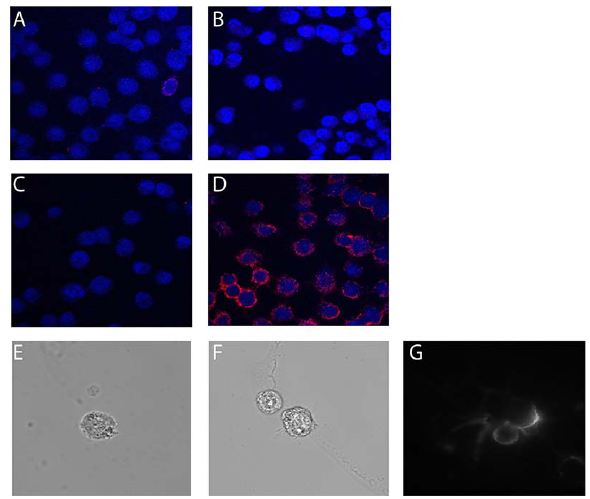
Figure 3. Immunofluorescence staining of undifferentiated HOG cells by 3064-BS (Myaptavin-3064). Live staining was performed on unfixed cells using ( A ) 100 nM 3060-BS, ( B ) 100 nM 3202-BS, ( C ) no aptamer conjugate, and ( D ) 100 nM Myaptavin-3064 for 1 h on ice. After washing, cells were fixed and stained with labeled anti-streptavidin antibodies and DAPI counterstaining of nuclei. Similar staining methods were applied to 1.5 mm poly-L-lysine-coated cover slips to determine cell surface binding of Myaptavin-3064 to HOG cells. There was no signal from negative control 3060-BS ( E ) or in the absence of aptamer conjugate ( F ). Myaptavin-3064 binds to the cell membrane of the HOG cells after 15 min of incubation as detected by total internal reflection fluorescence (TIRF) microscopy using live cell staining ( G